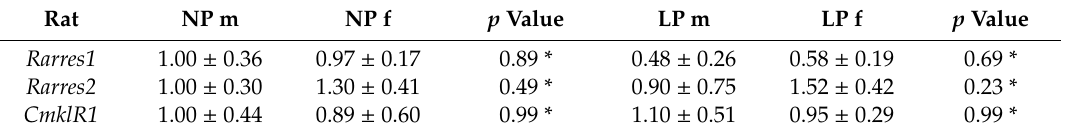
Table 2. Sex differences in mRNA expression (fold-change). Table 2. Sex di ff erences in mRNA expression (fold-change).